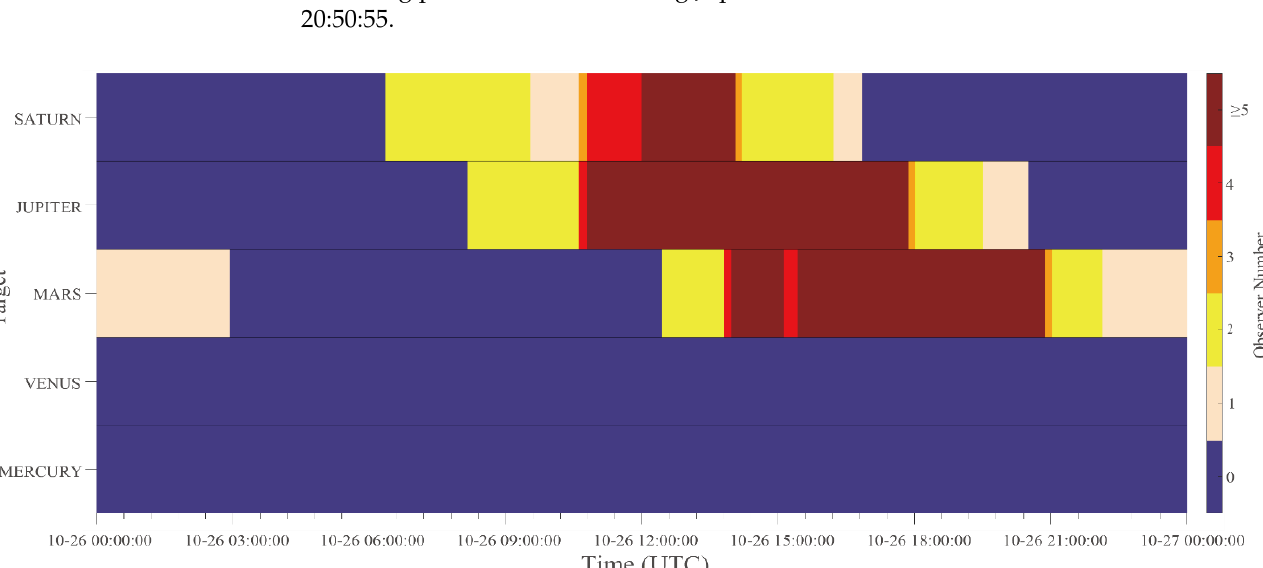
Figure 13. Observation windows for joint observations of five targets on 26 October 2022.